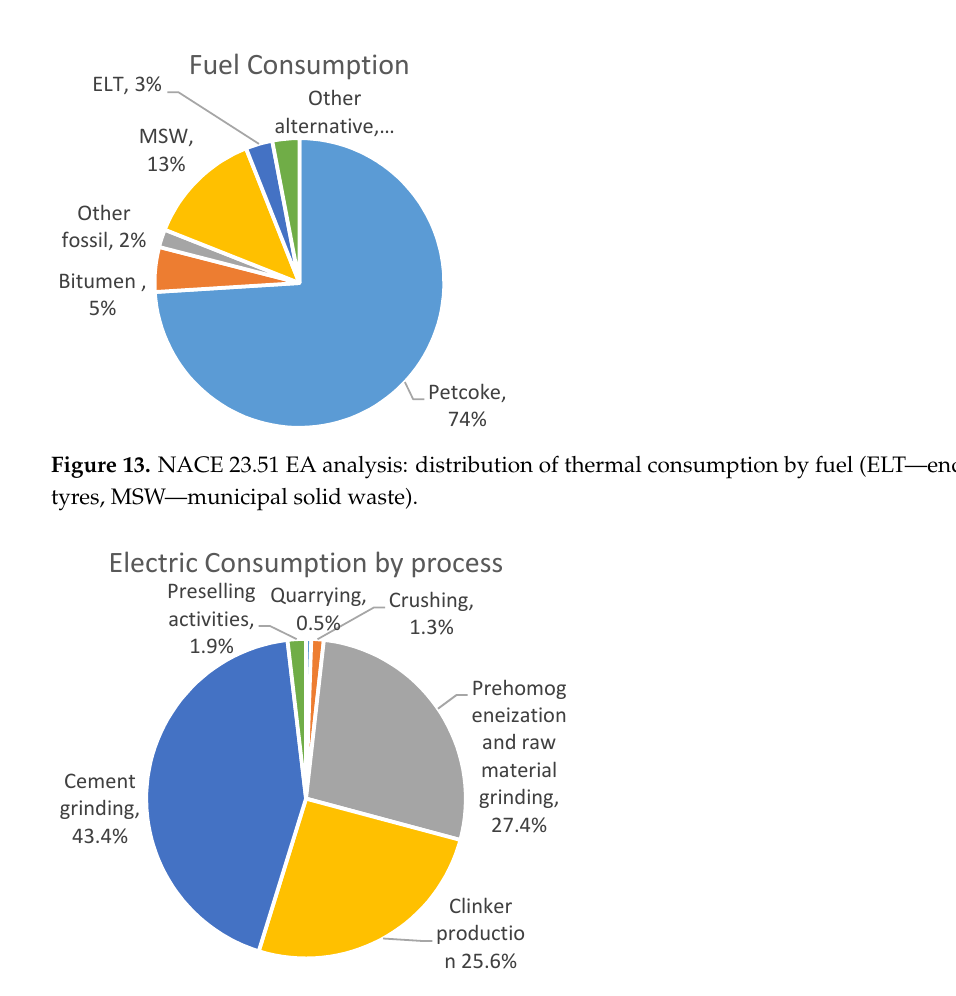
Figure 14. NACE 23.51 EA analysis: distribution of electric consumption by activity.